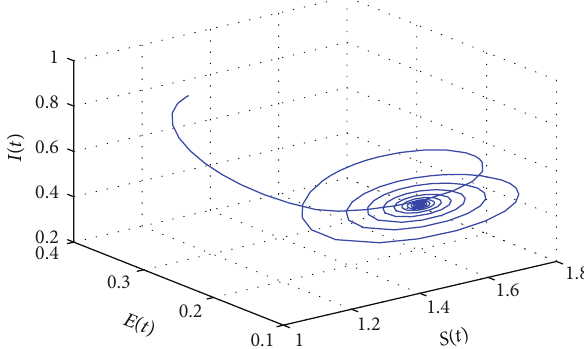
Figure 4: The phase plot of the states 𝐸 , 𝐼 , and 𝑅 for 𝜏 = 10.025 > 8.9829 = 𝜏 0